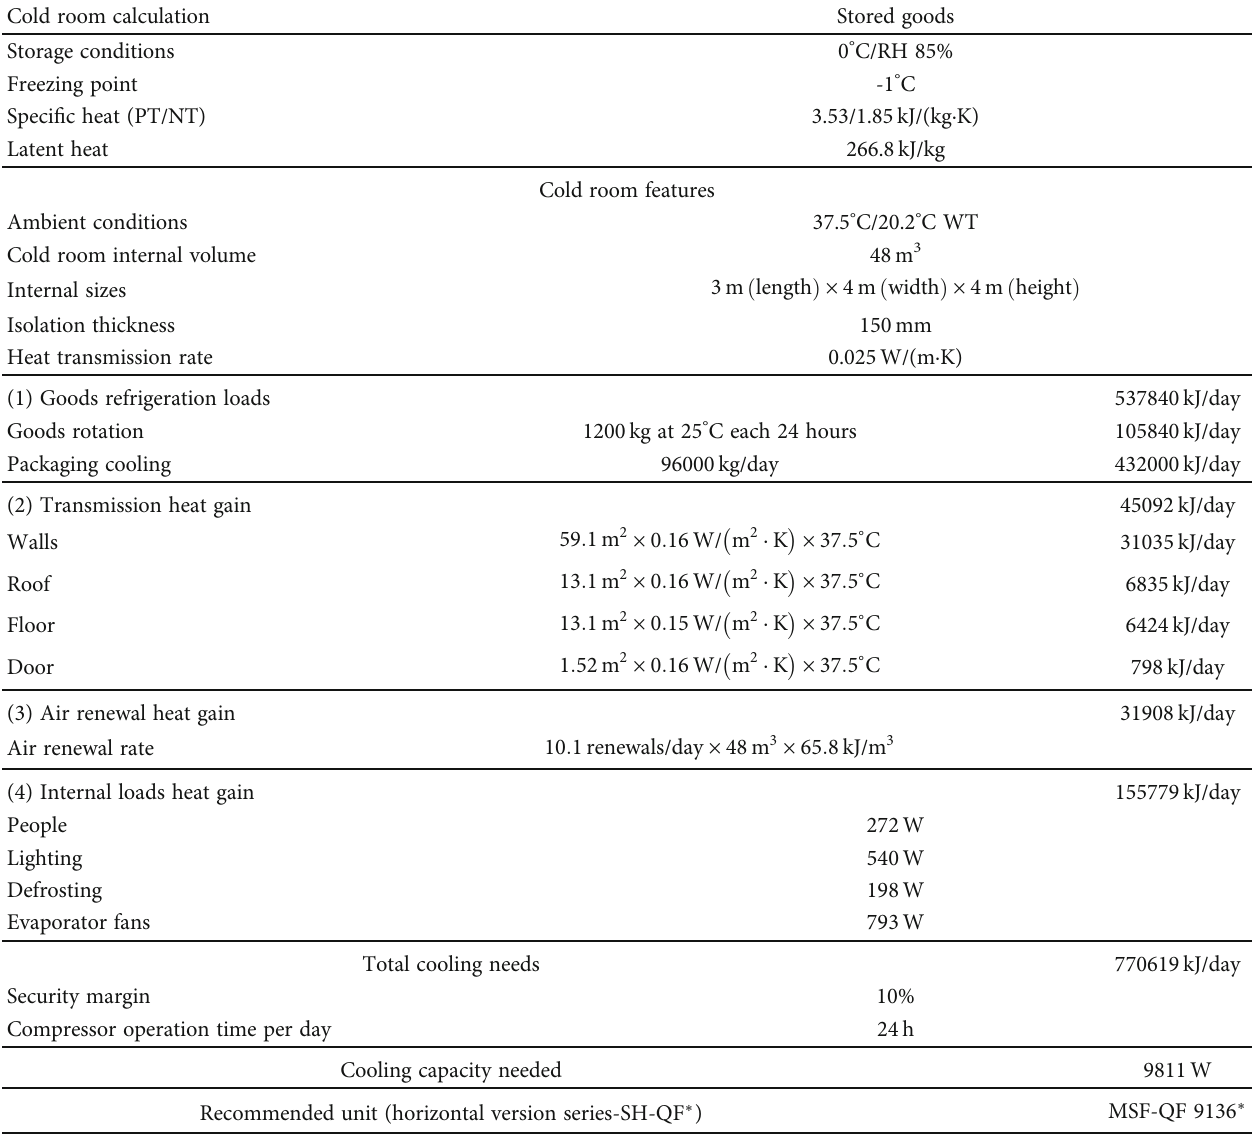
Table 3: Stored goods conditions and cold room